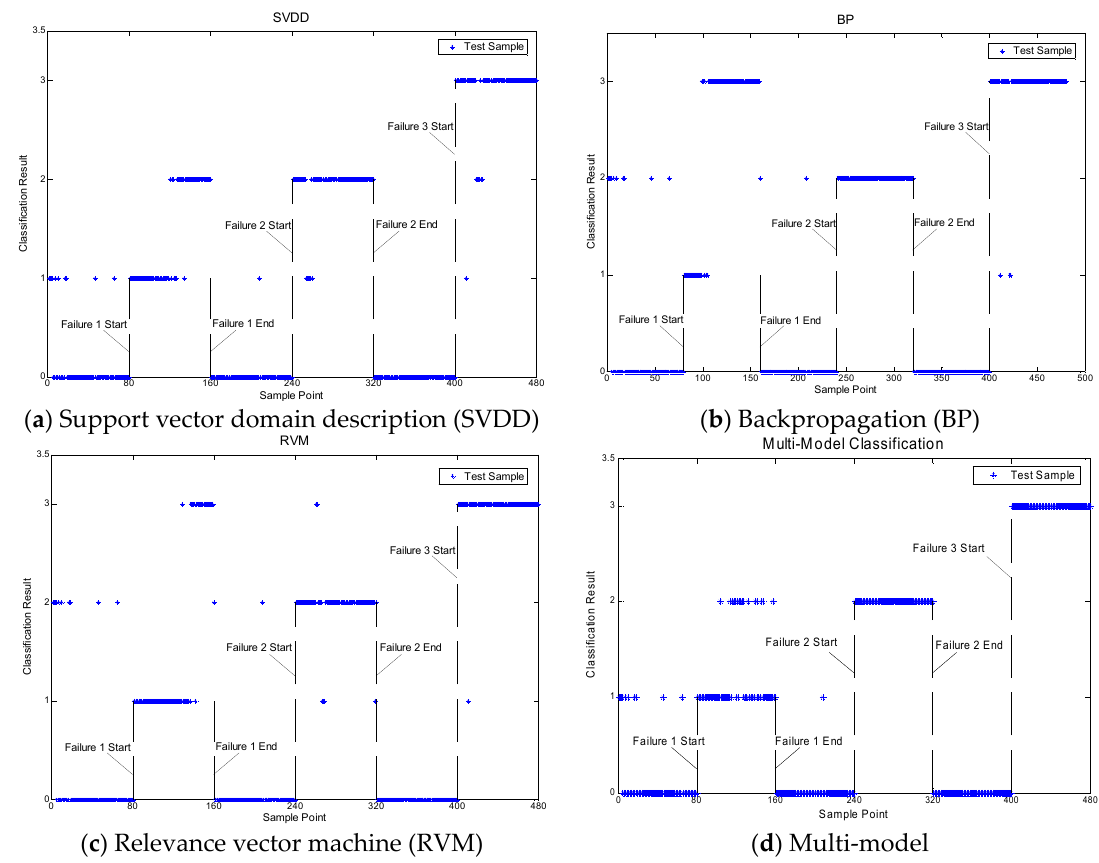
Figure 9. Classification result with the single multi-model approach.